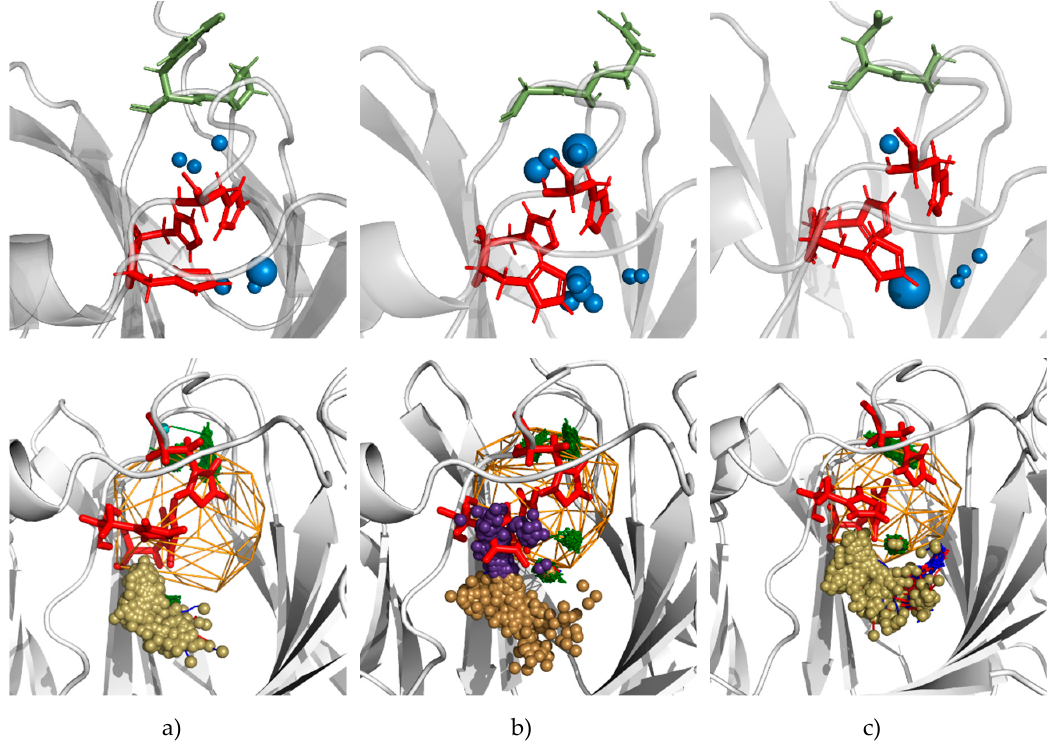
Figure 7. Pictures of water distribution (upper row) and water trajectories (lower row) in the vicinity of the Mn ion in molecular dynamics (MD) simulations of: ( a ) WT chain A (no or small movement of His88, observed in all variants representative for variants with similar to WT activity); ( b ) RG mutant chain B (with His88 rotation observed in chain B of mutants with higher activity), and ( c ) AD chain A (no rotation of His88, lowest water density, observed in mutant with lowest activity). Pictures were generated with PyMOL software based on AQUA-DUCT results. The water distribution pictures present water hot spots as blue spheres with size proportional to the local density of water molecules. Protein backbone - grey cartoon representation; His 88, 90, 136 - red stick representation; residues 132 and 133 - green stick representation; object - orange mesh; inlets - small balls. Green lines depict trajectories of trapped water molecules. Inlets colors: gold - main cavity cluster, violet - cluster observed due to His88 rotation, cyan - rear-side cavity cluster.